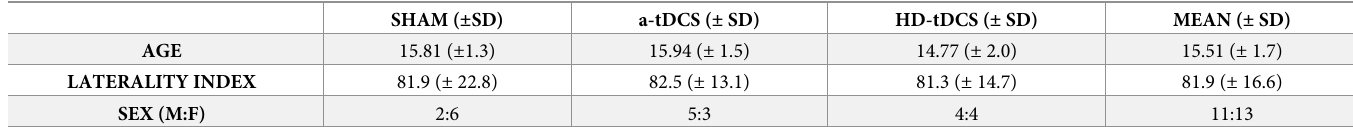
Table 1. Mean participant demographics ± 1 standard deviation for all stimulation intervention groups. No significant difference between groups was